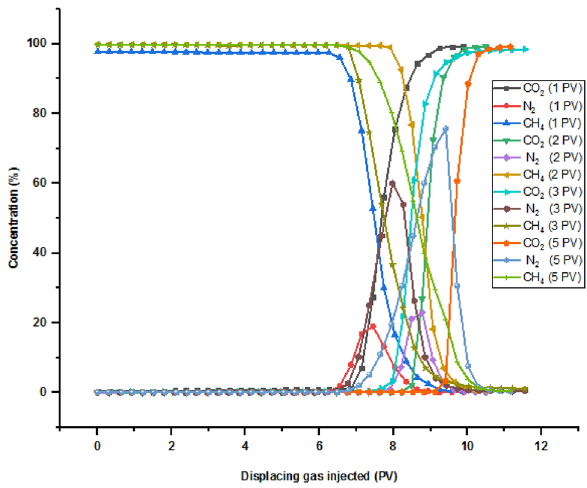
Fig. 12 Concentration profiles of all the runs with cushion gas